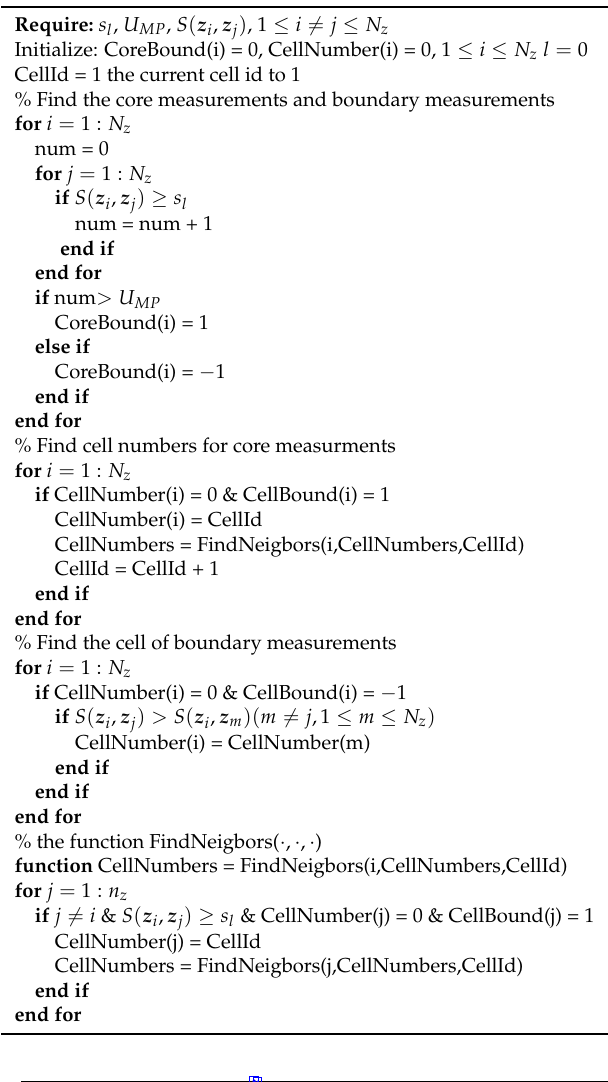
Table 1. The pseudo-code of the SNNDP.